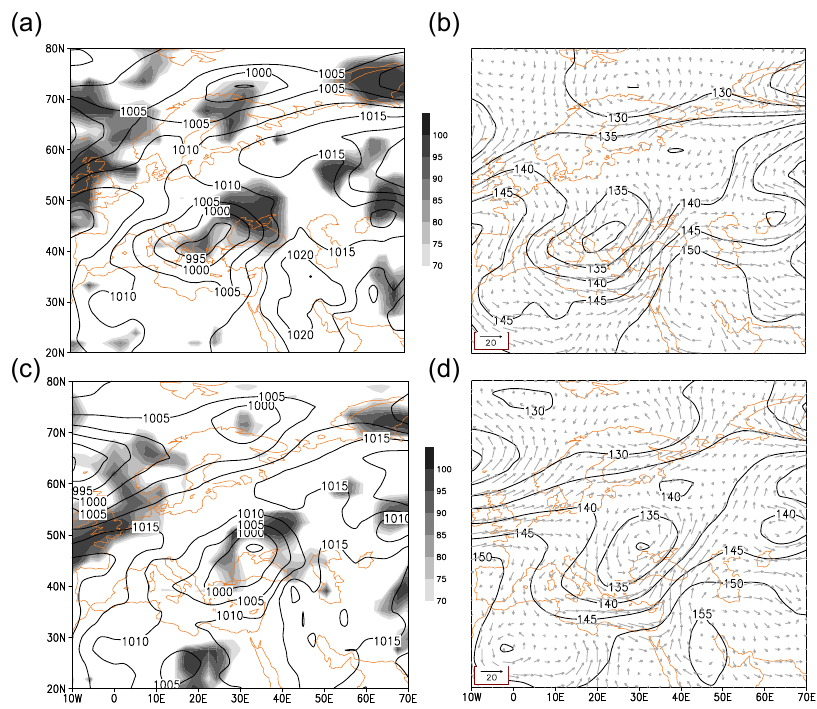
Figure 8. The evolution of the second dust storm event over Turkey at 00:00 UTC 24 March 2016. ( a ) sea level pressures (solid lines, every 5-hPa), and total cloud cover (shaded, %) at surface. ( b ) Height (solid lines, dam) and winds (m·s − 1 ) at 850-hPa. (c) same as ( a ) and ( d ) same as ( b ) but for 12:00 UTC of the 24 March.